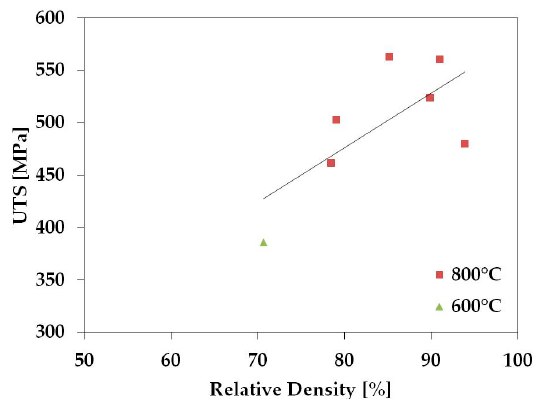
Figure 8. Ultimate tensile strength values for TNZT samples sintered at different temperatures (red square 800 °C and green triangle 600 °C) without holding time and their relation to relative density.